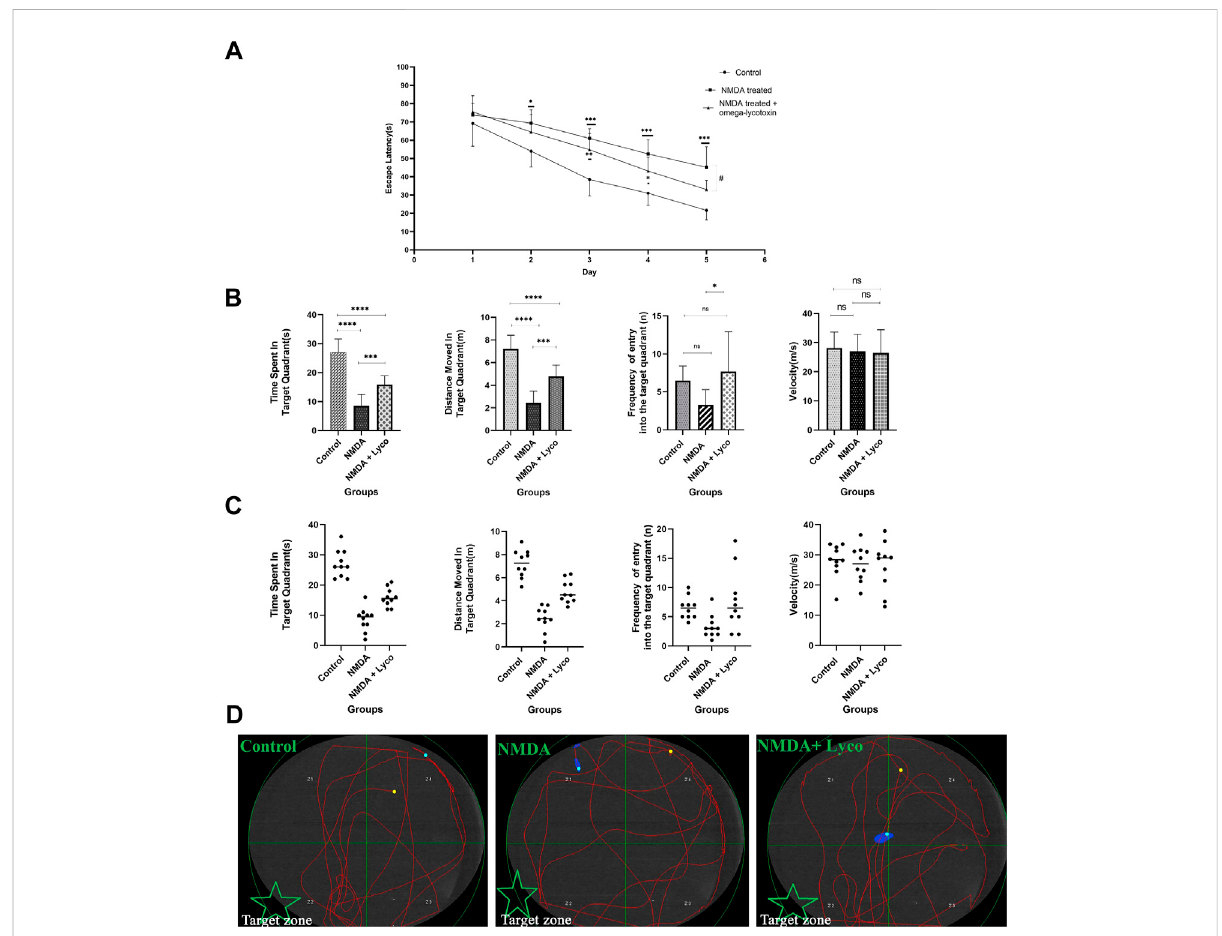
The Morris water maze test (A) The effect of treatment with OLG1e on the average escape latency time during the training days. The data are shown as means ± SEM of 10 rats per group. (* p < 0.05 and ** p < 0.01 and *** p < 0.001 and **** p < 0.0001) and (# p < 0.05). (B) The effect of treatment with OLG1e on time spent in the target quadrant, distance moved in the target quadrant, frequency of entry into the target quadrant from thetestday.Thedataareshownasmeans±SEMof10ratspergroup(* p < 0.05and** p < 0.01and*** p < 0.001and**** p < 0.0001). (C) Scatter plot of part (B) (D) The swim path traces from the test day. The target zone is indicated with green